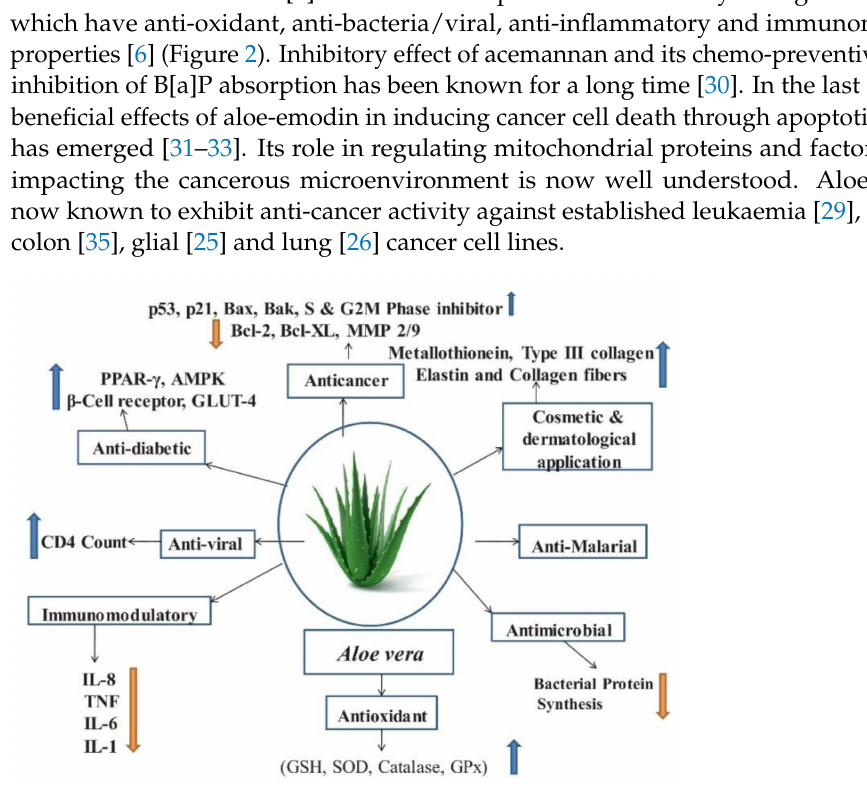
Figure 2. Schematic outlining the biological properties of Aloe vera . Reproduced with permission from [2]; copyright Elsevier,